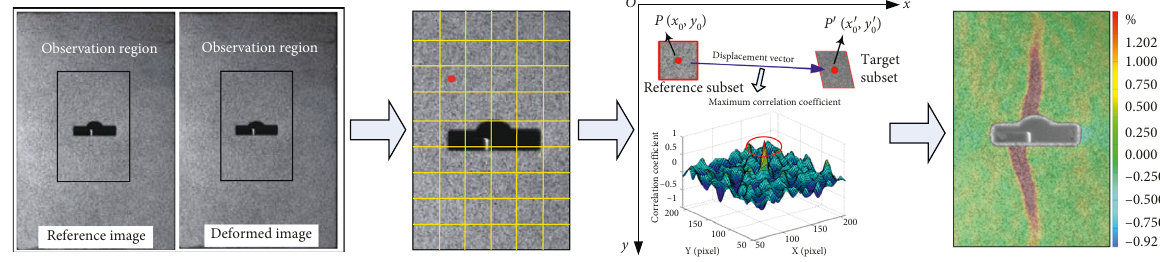
Figure 3: Procedures of DIC calculation.